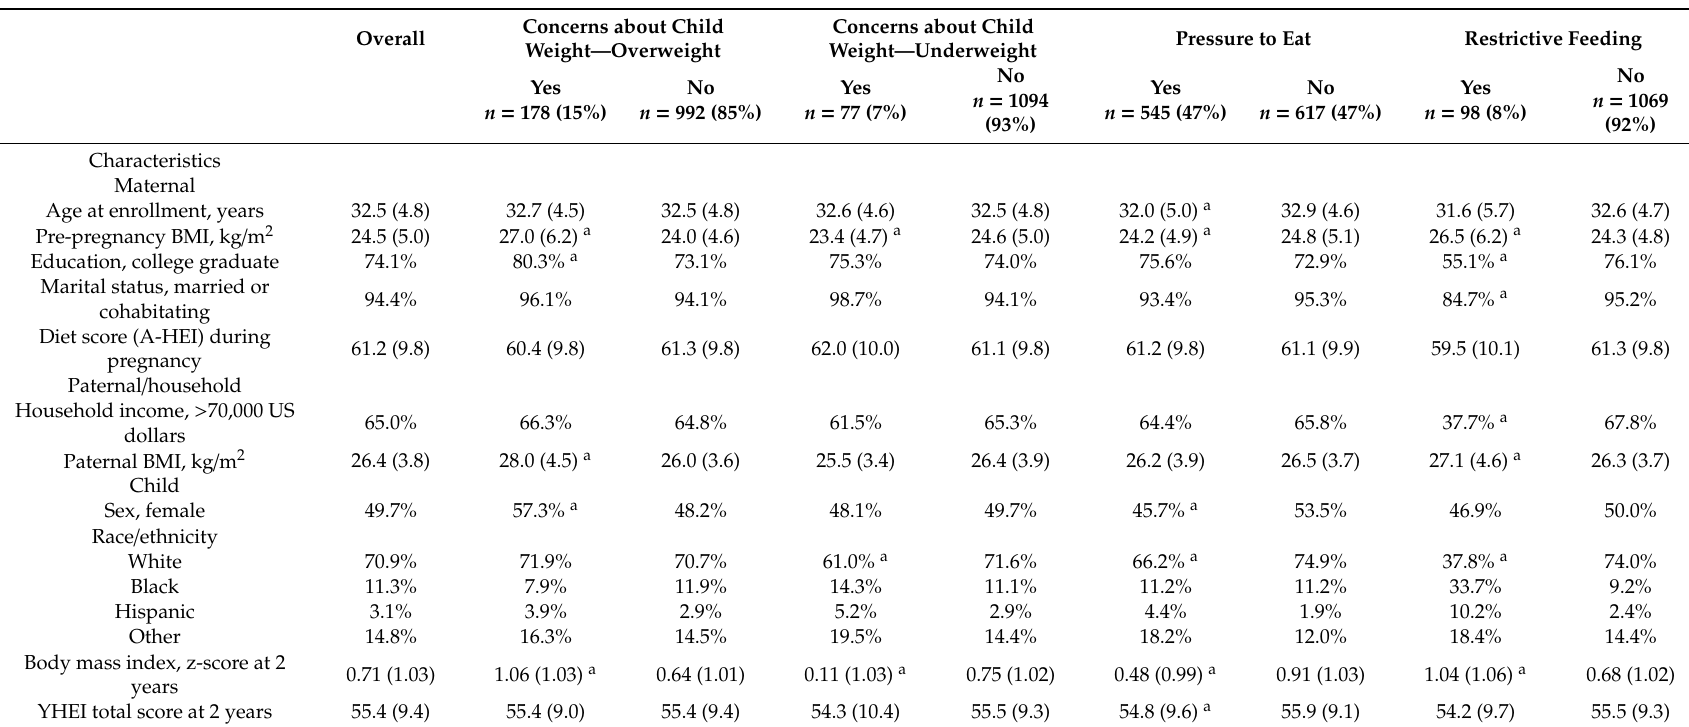
Table 1. Parental, household, and child characteristics by parental feeding concerns and practices at 2 years among participants from Project Viva (Mean (SD) or